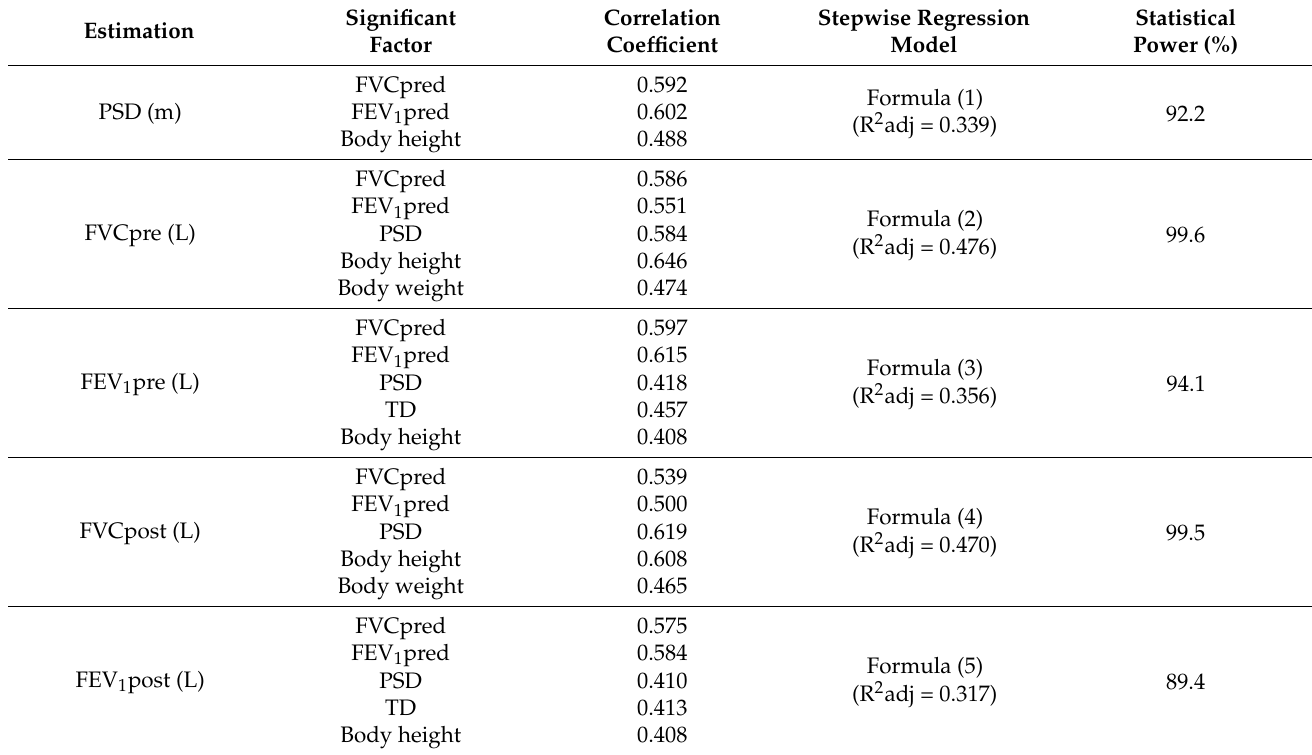
Table 2. Predicted models for dependent